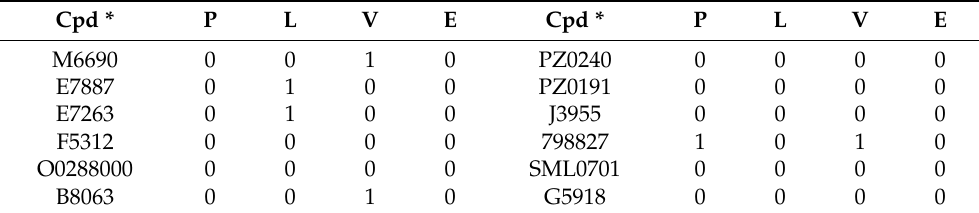
Table 2. Drug-likeness parameters calculated for the selected compounds. Cpd